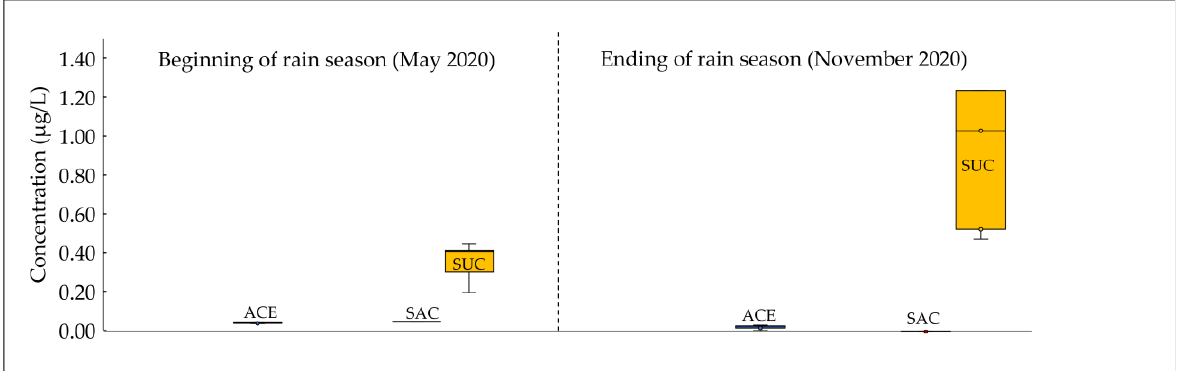
Figure 5. Box and whisker plots showing the seasonal concentrations of Asws in five wells clustered in the transition zone (group 2) in the MMA. The whiskers indicate the max and min. The box stretches from the lower to upper hinges (25th to 75th percentiles). The mean is shown as a line across the box.